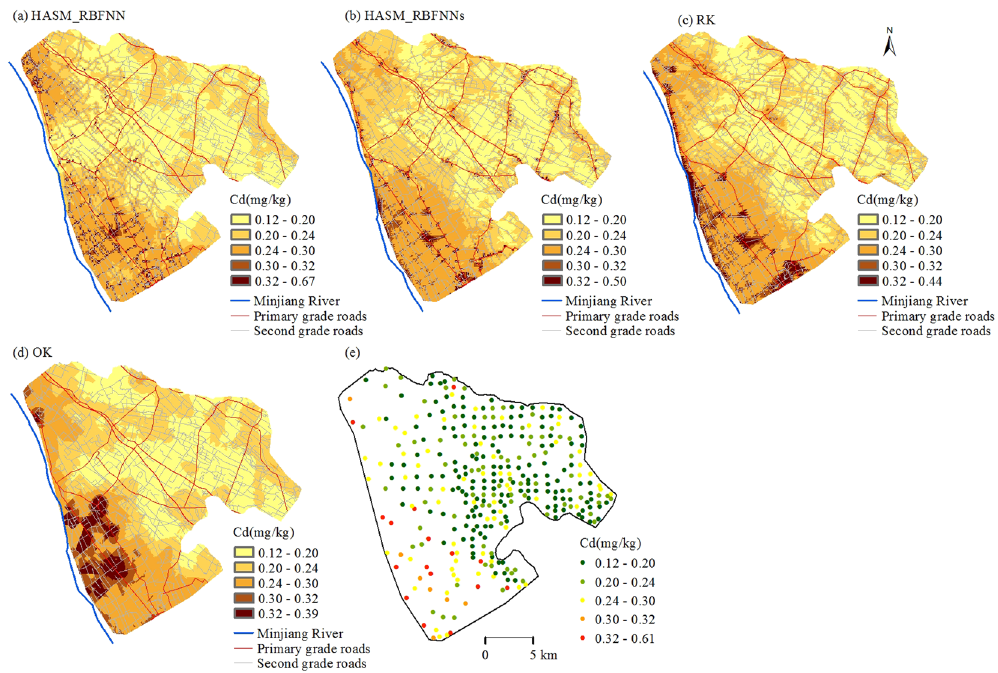
Figure 2. The spatial distribution maps by HASM_RBFNN ( a ), HASM_RBFNNs ( b ), RK ( c ) and OK ( d ). (OK, ordinary kriging; RK, regression kriging; HASM_RBFNN, the combined method (HASM_RBFNN) developed using high-accuracy surface modelling (HASM) and radial basis function neural network (RBFNN) modelling, taking into account the spatial non-stationarity of the relationships between soil Cd and the auxiliary variables; HASM_RBFNNs, the combined method (HASM_RBFNN), without taking into account the spatial non- stationarity of the relationships.). All the maps were generated in ArcGIS10.1, http://www.esrichina-bj.cn/